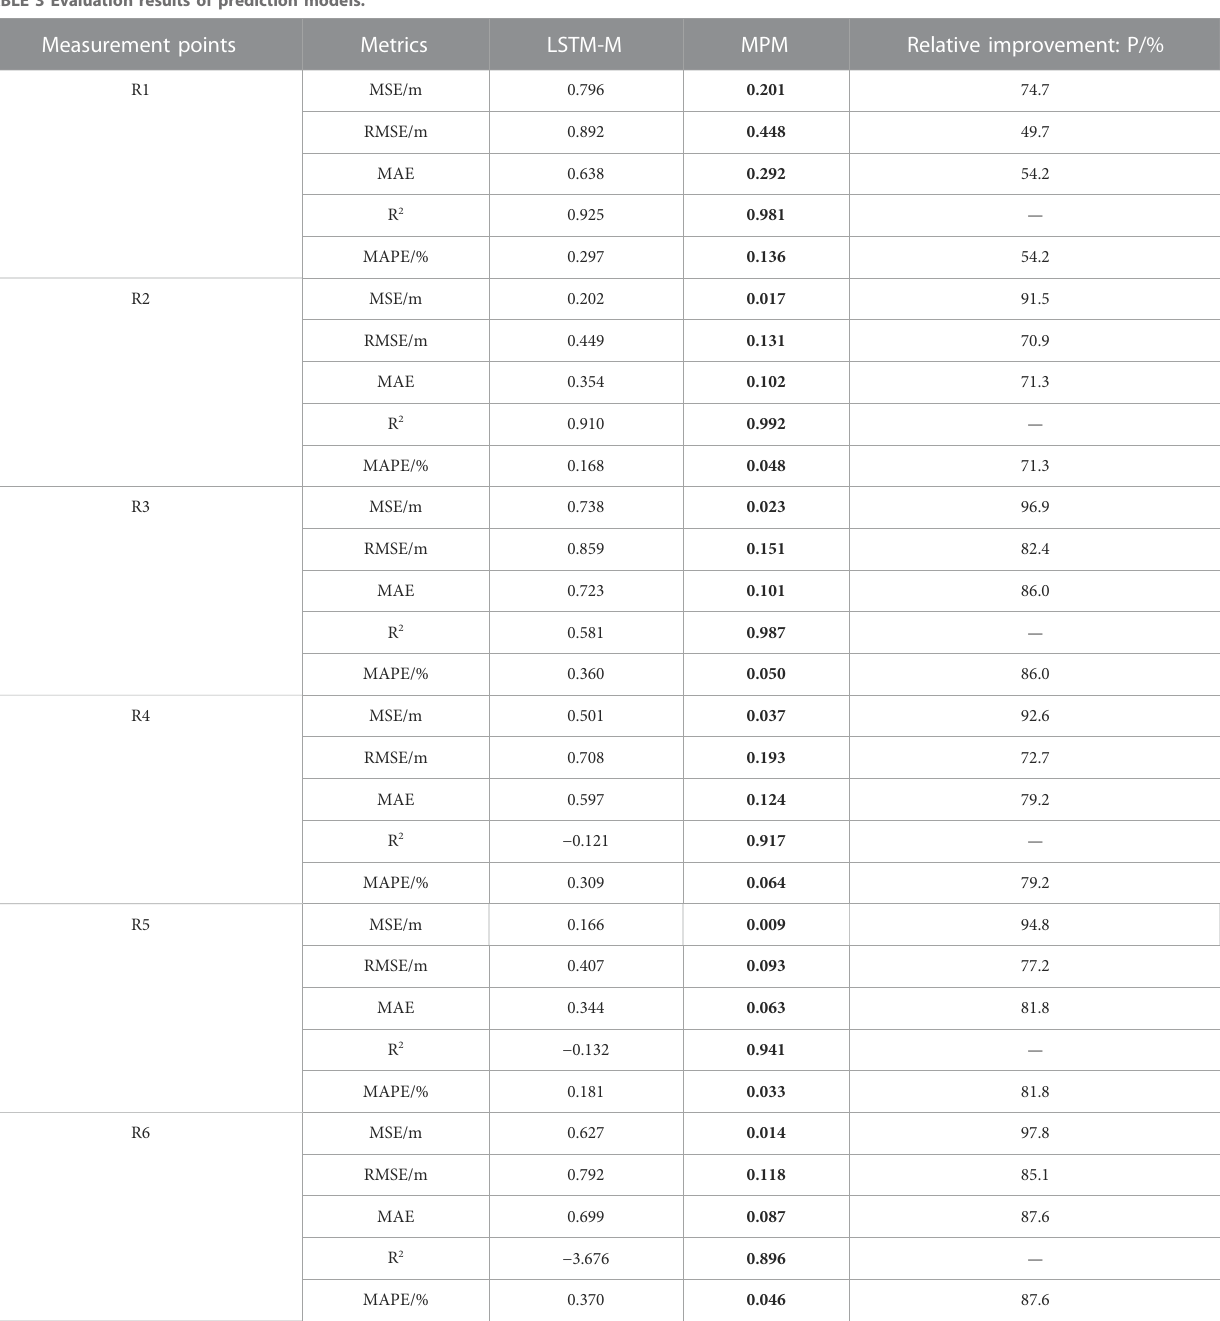
TABLE 3 Evaluation results of prediction models. Measurement